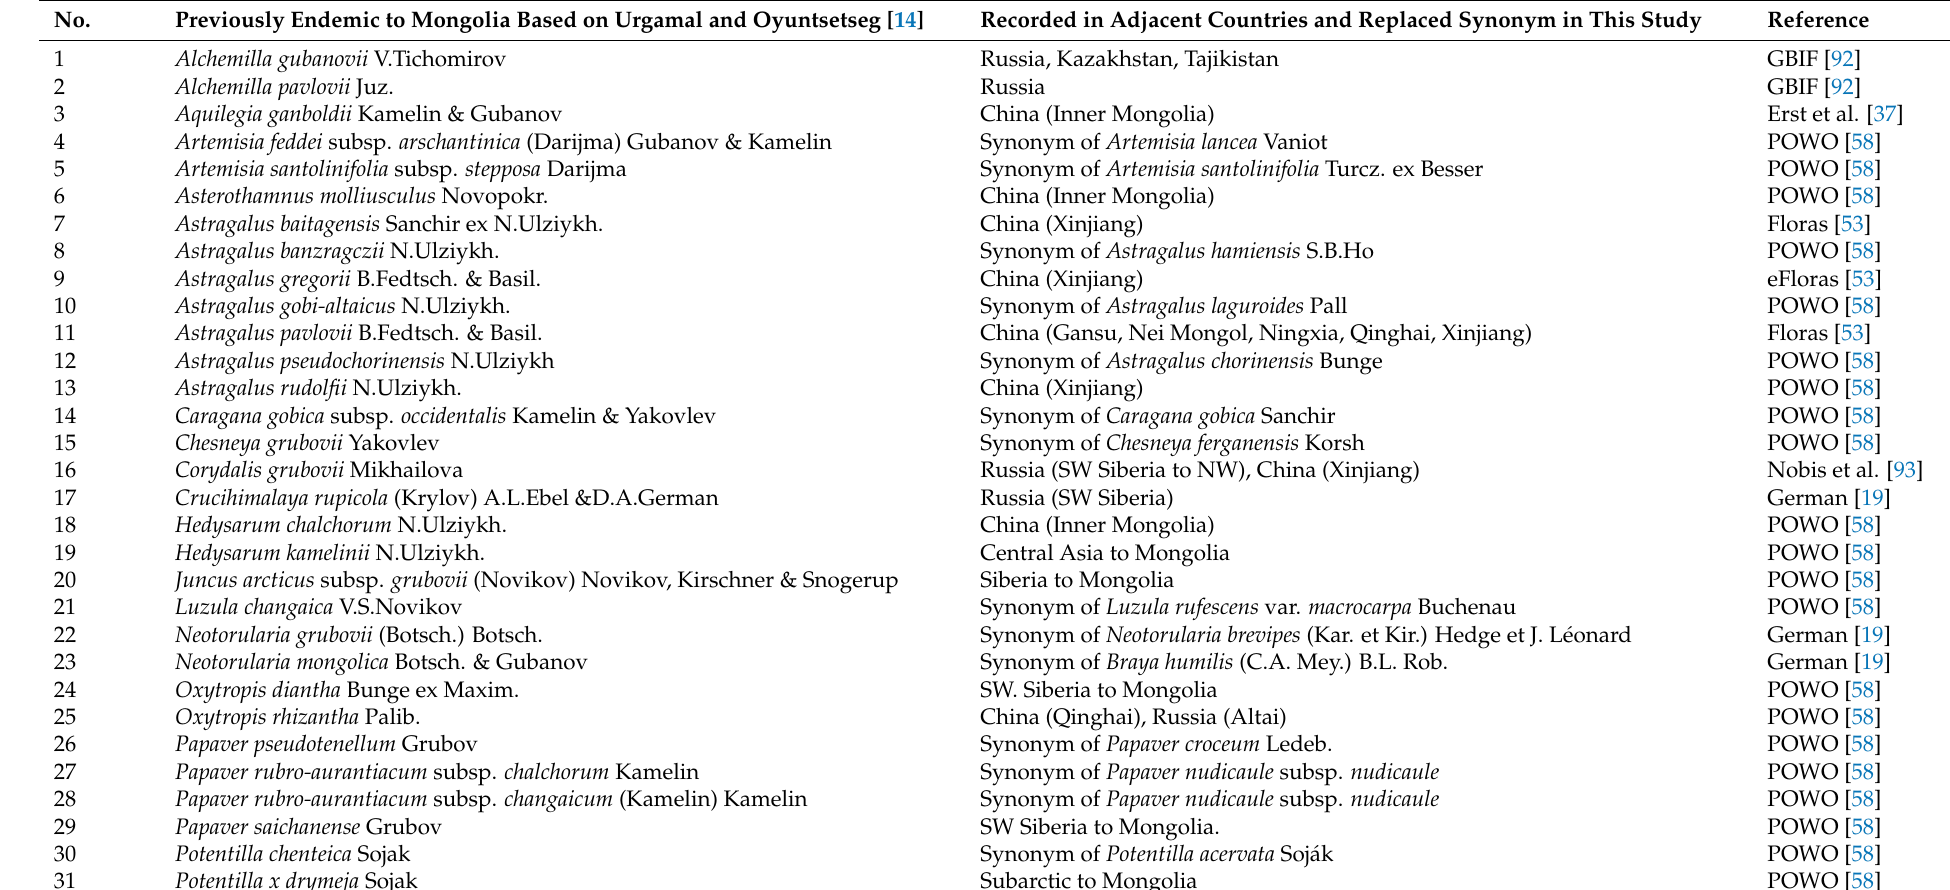
Table A1. List of excluded endemic taxa in this